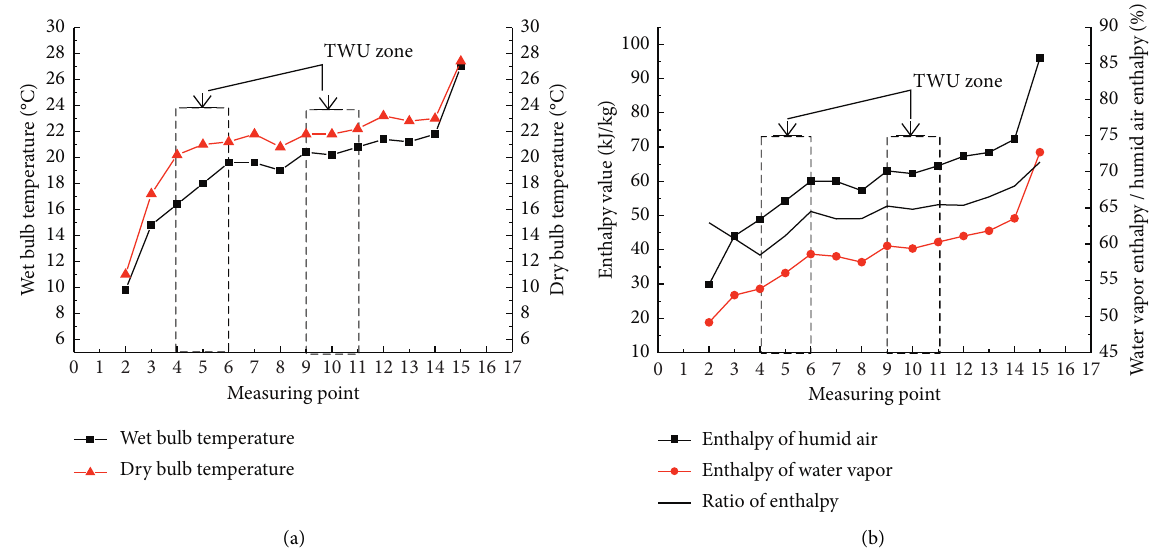
Figure 3: Measuring result of mine microclimate